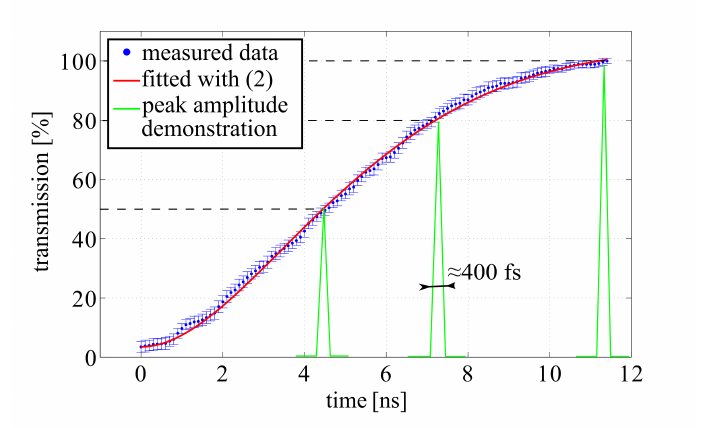
Figure 2. Transmission versus time for the rising edge of the Pockels